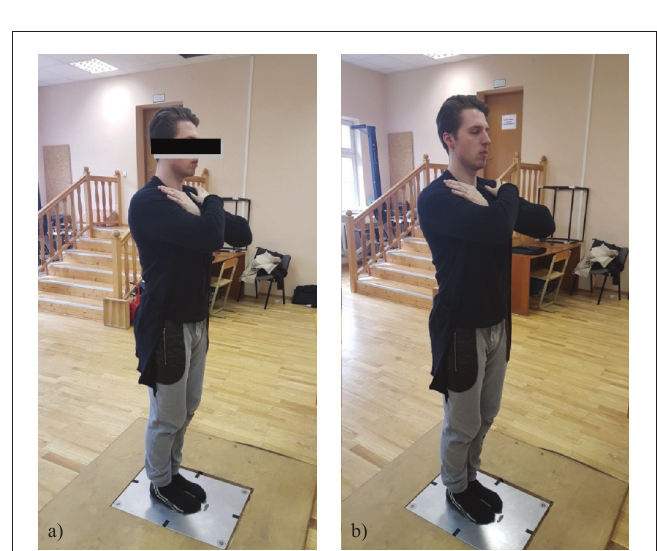
Figure. Standing positions on the balance